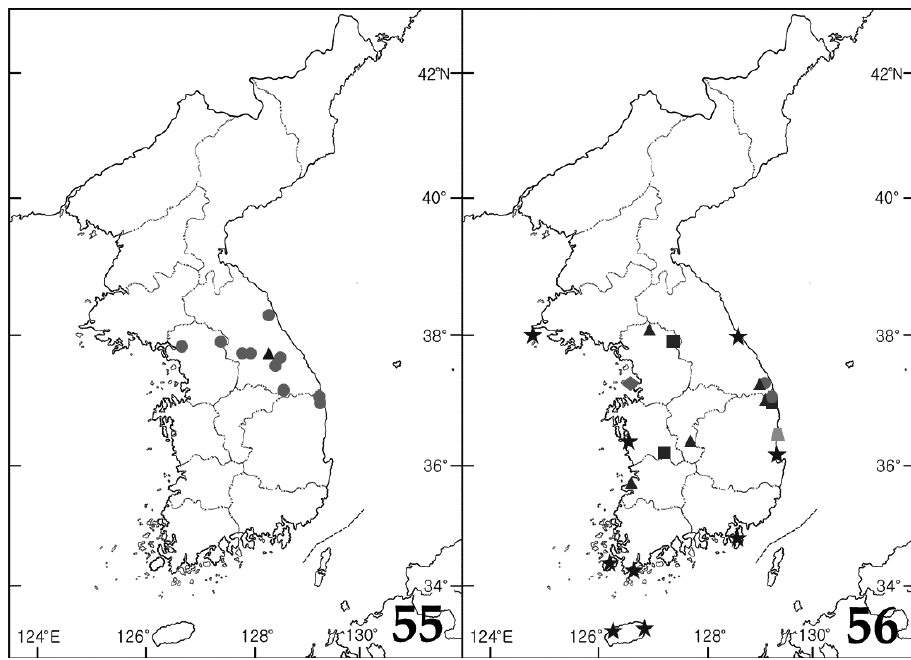
Figures 55–56. Distribution maps. 55 Hydraena puetzi (circle), H. miyatakei (triangle) 56 Ochthebius ahni (trapezoid), O. lobatus (circle), O. marinus (diamond), O. parki (star), O. satoi (triangle), O. hasega- wai